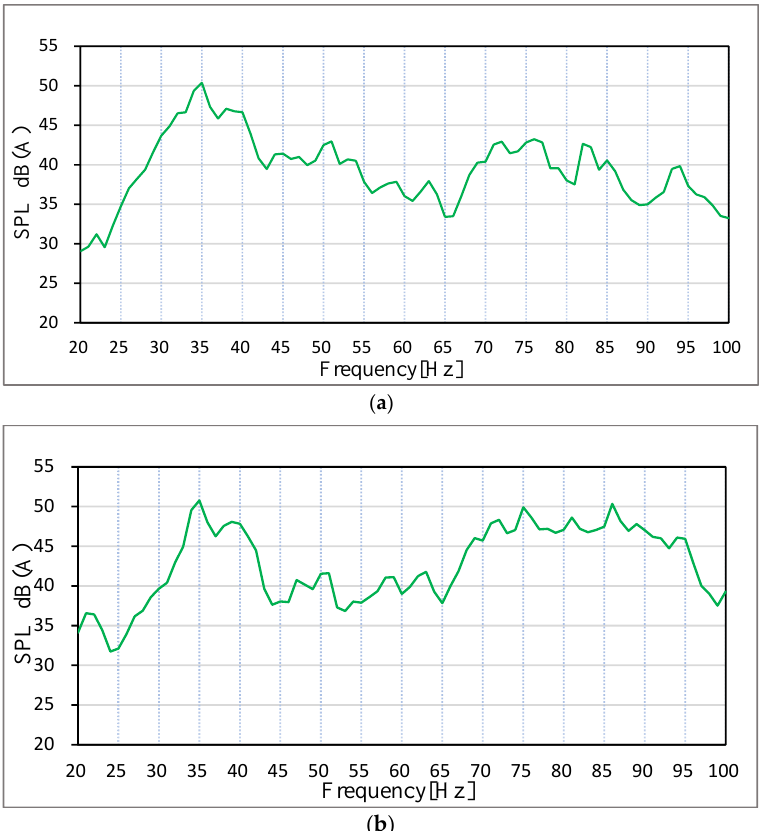
Figure 4. Position of sound pressure sensors. ( a ) driver’s seat , ( b ) passenger’s seat .